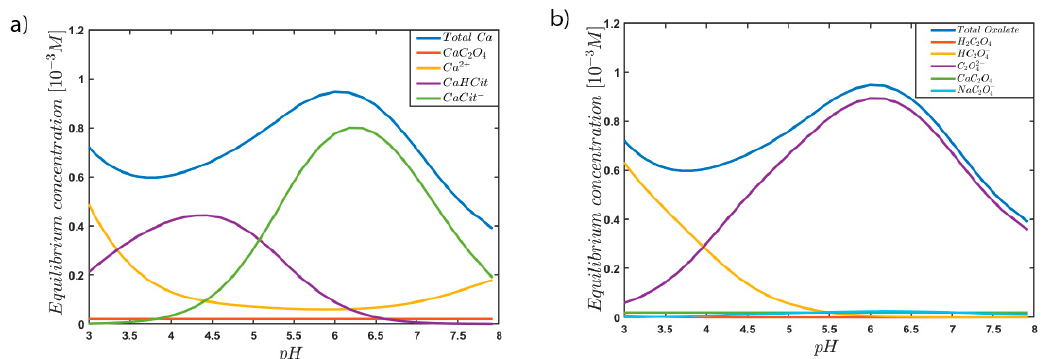
Figure 6. Simulated equilibrium concentrations of the Calcium ( a ) and the oxalate ( b ) species at various pH in citric acid-disodium phosphate buffer at 37 °C.